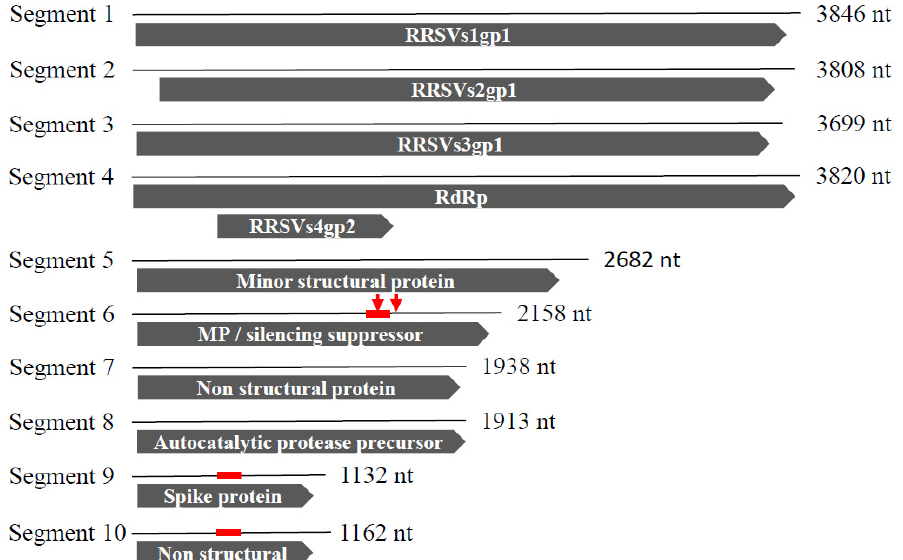
Figure 1. Rice ragged stunt virus (RRSV) multipartite genome. Each of the 10 RNA segments is represented. Black lines correspond to RNA genomes and gray arrows represent ORFs. Names or functions of ORFs, when they are known, are noted in white. The name and size of each RNA segment are indicated. The positions of artificial miRNA targets are indicated by red arrows on segment 6. Sequences selected to construct the chimeric RRSV double strand are indicated by red lines on segments 6, 9, and 10.